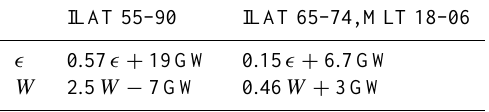
Table 3. Joule heating as a function of epsilon parameter ( (cid:15) ) and